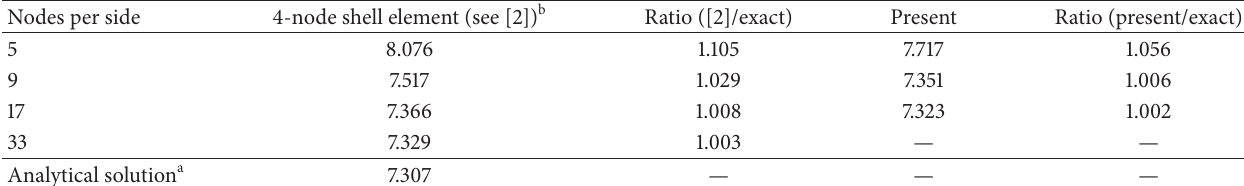
Table 2: Normalized nondimensional natural frequency of S-FGM plate (power law index: 𝑝 = 10 ). Nodes per side